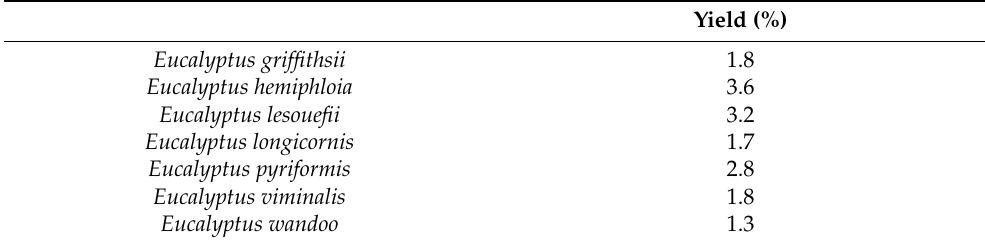
Table 1. Essential Oil Yields of seven Eucalyptus